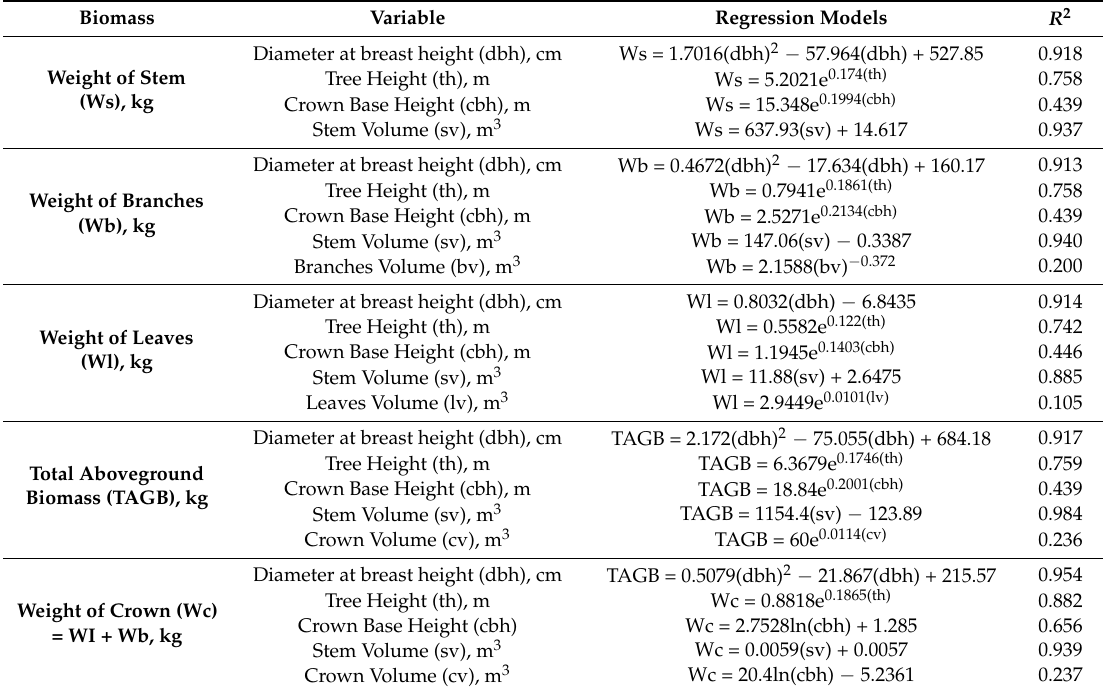
Table 4. General allometric equation for all tree species with tree variables obtained from